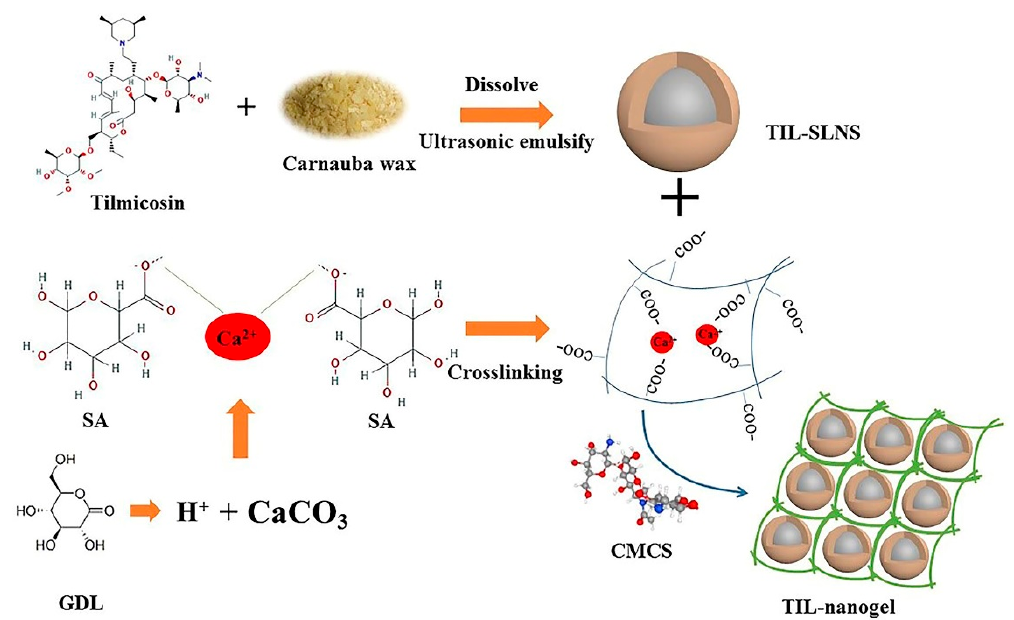
Figure 1. The preparation process of tilmicosin-loaded solid lipid nanoparticles (TIL-SLNs) and TIL-nanogel. CMCS, carboxymethyl chitosan; GDL, gluconolactone; SA, sodium alginate.